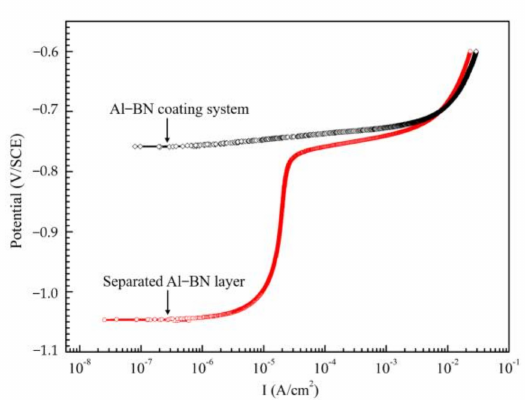
Figure 3. The initial anodic polarization curves of Al–BN ACS and separated Al–BN layer in 5.0 wt % NaCl solution.